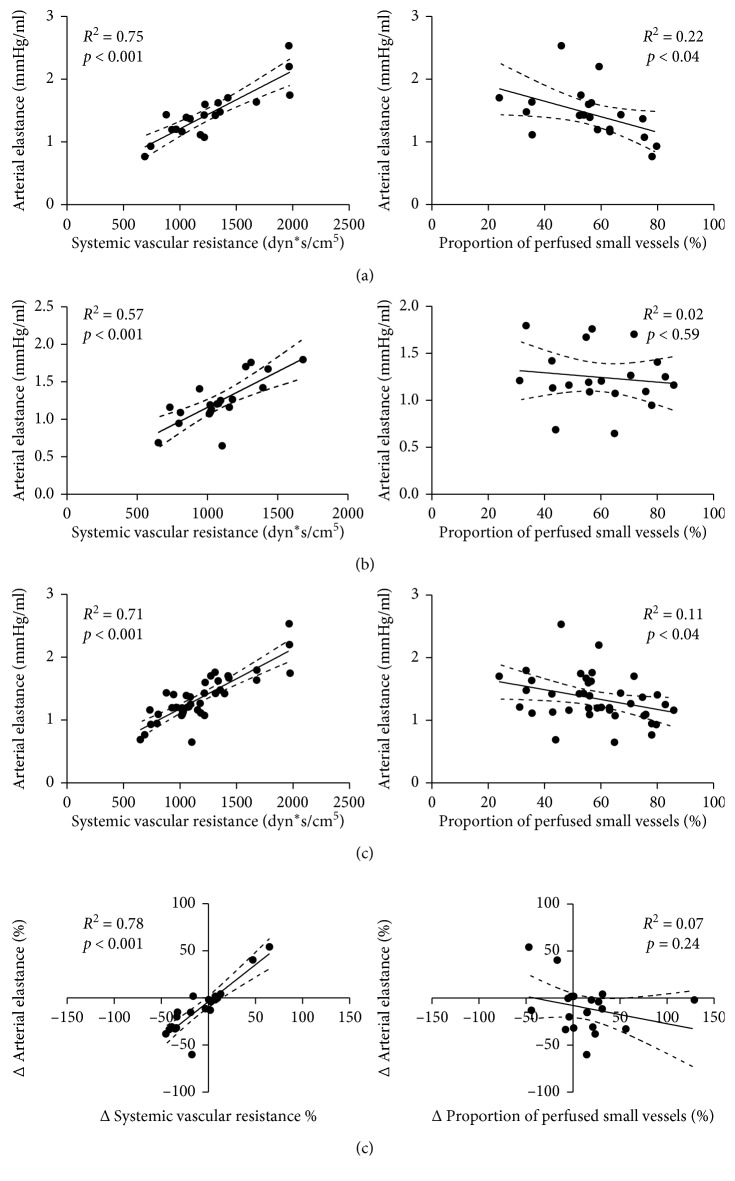
Correlation between arterial elastance and systemic vascular resistance (left column) and between arterial elastance and proportion of perfused small vessels (right column). (a) Baseline (T0); (b) after fluid challenge (T1); (c) all data (baseline plus after fluid challenge); (d) percentage of change between baseline and after fluid challenge.